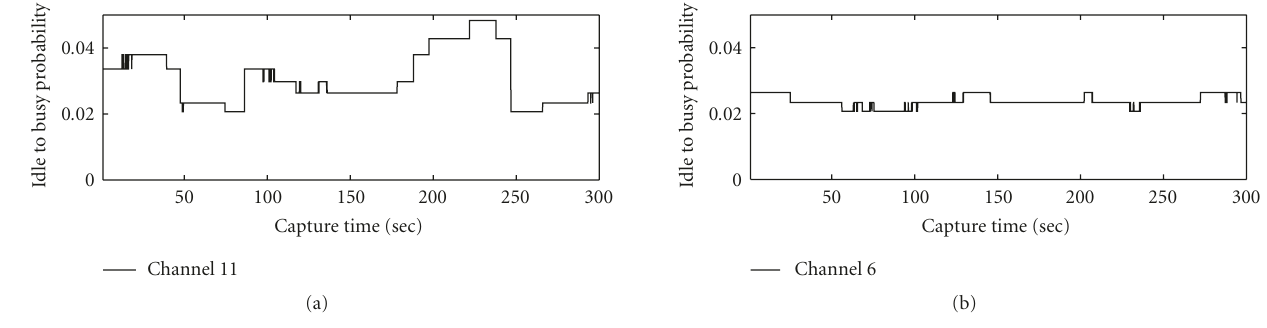
Figure 4: The idle-to-busy probability q , characterizing the idle time distribution varies over time.